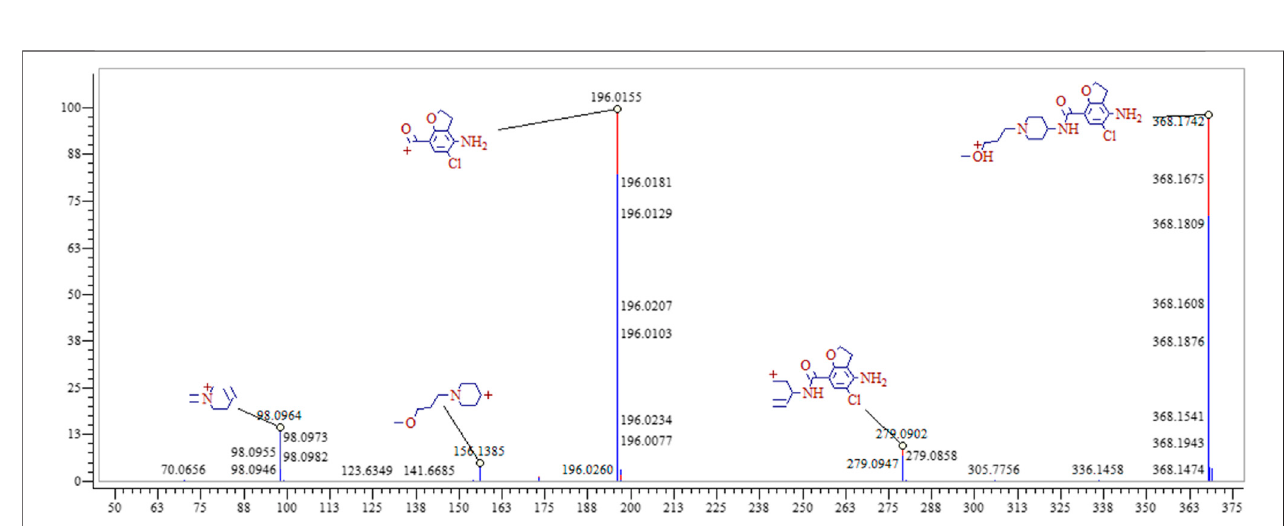
FIGURE 6 | The MS 2 spectrum and corresponding fragment ions of